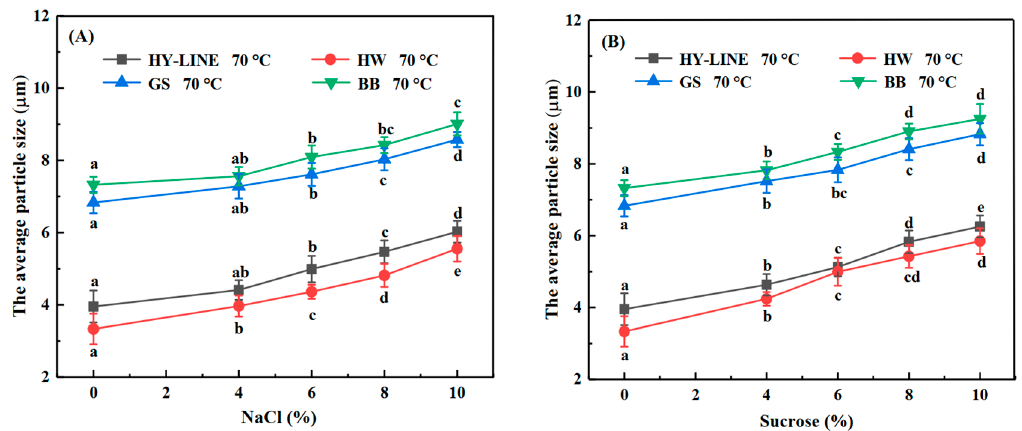
Figure 5. Average particle size of four varieties of EWs after heat treatment. ( A ) Average particle size of four varieties of EWs with different NaCl concentrations after heat treatment. ( B ) Average particle size of four varieties of EWs with different sucrose concentrations after heat treatment. Three replicate samples were measured for each treatment.